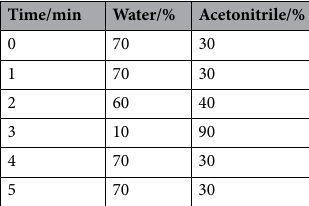
Table 5. Gradient condition of a mobile phase composed of two solutions.